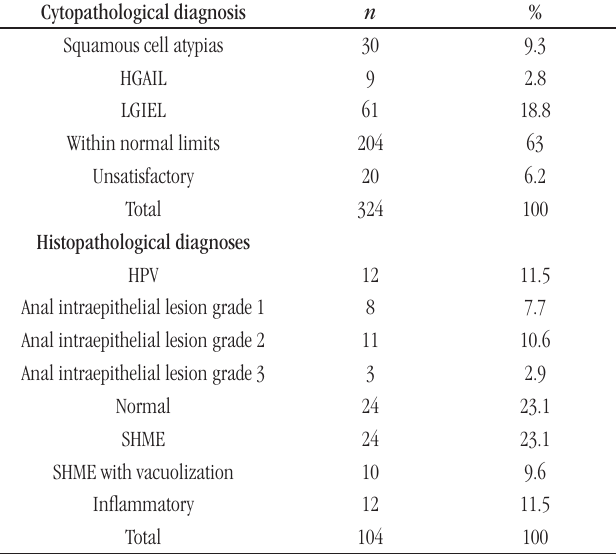
taBLE 1 – Cytopathological consensus diagnoses and anal histopathological anal diagnoses in women with cervical